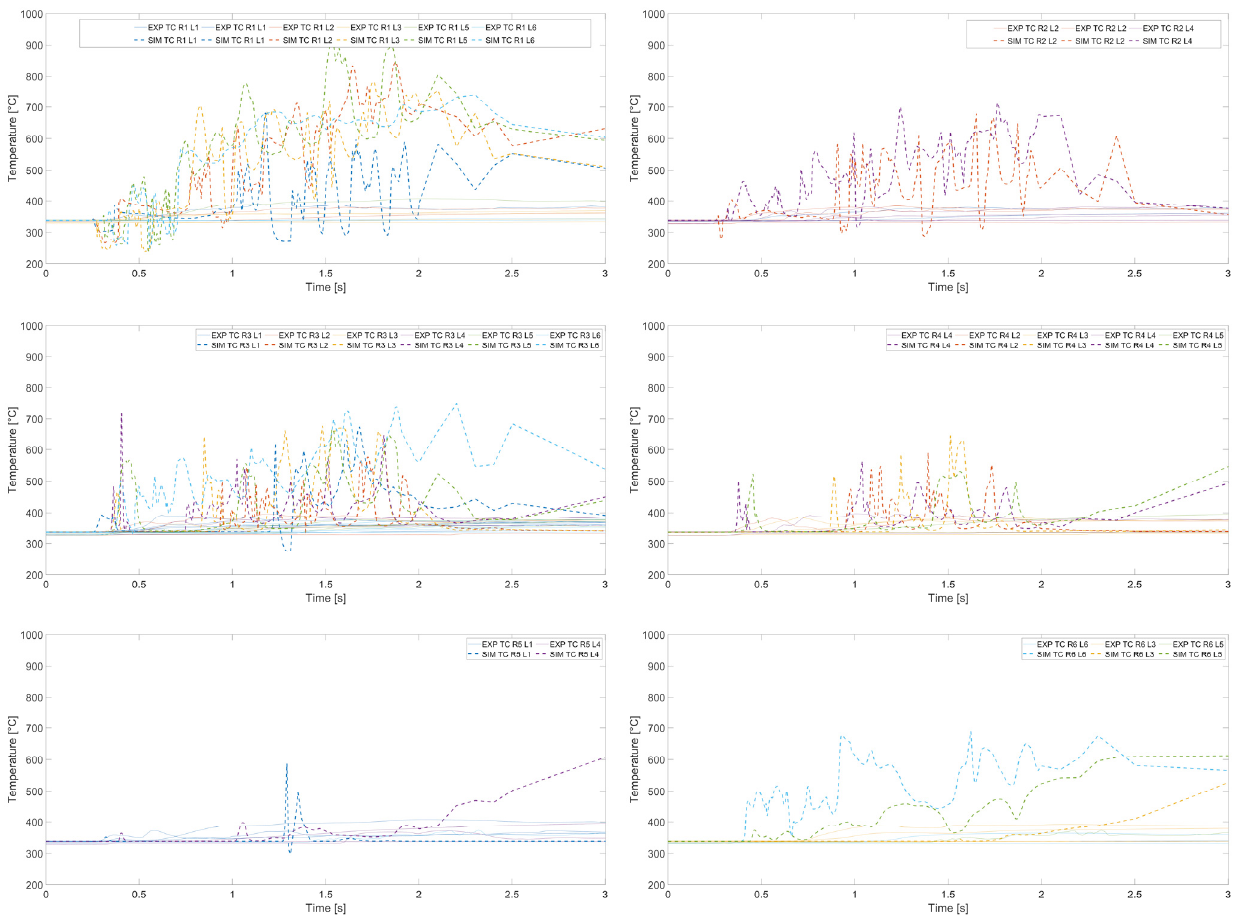
Figure 17. Temperature evolution in S1B for standalone simulations at different radial and axial positions (refer to Table 5).